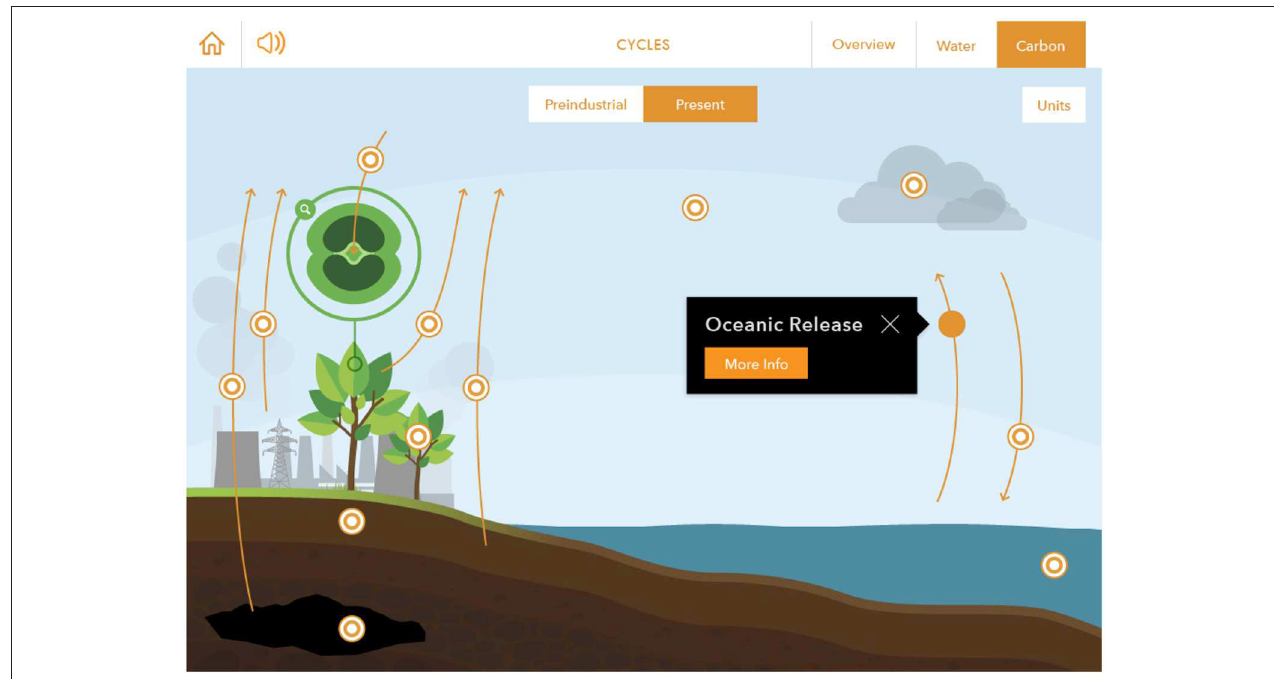
FIGURE 2 | Screenshot from the Global Change App. The user interactively learns about the global carbon and water fluxes and pools, how human activity affects them, and how they are